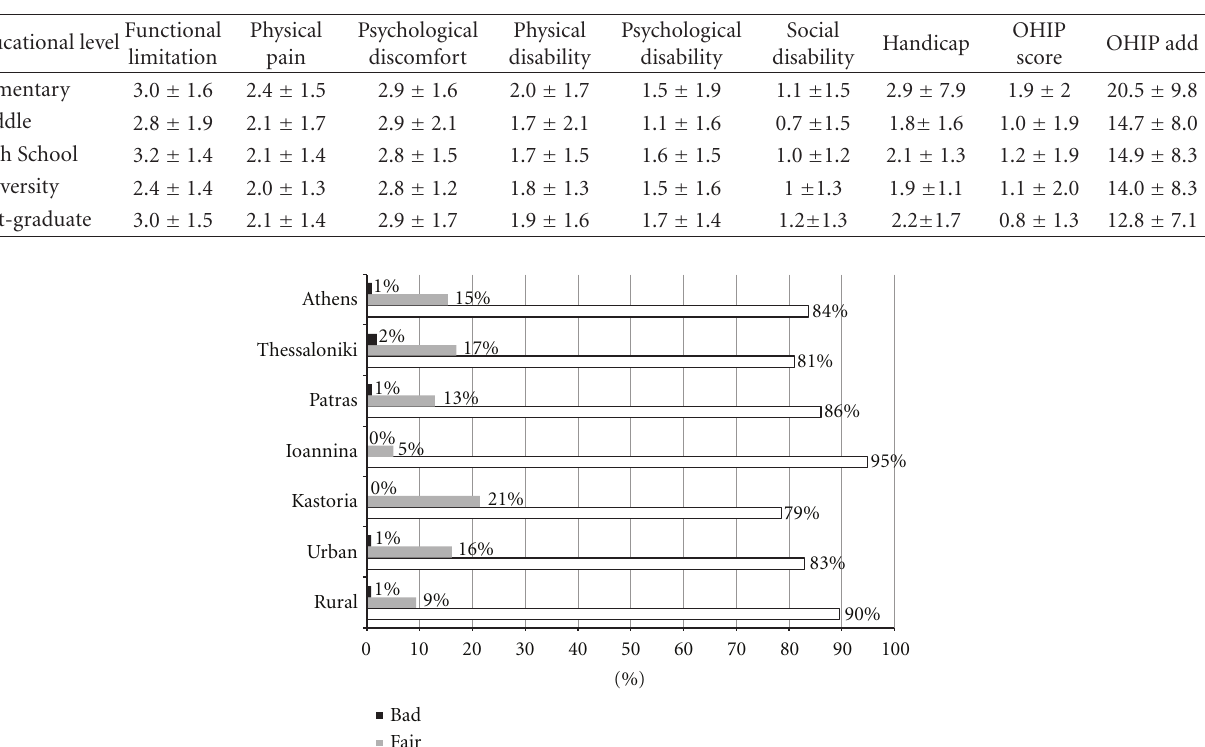
Table 3: Mean OHIP-14 for the subscales and total scores according to educational level.